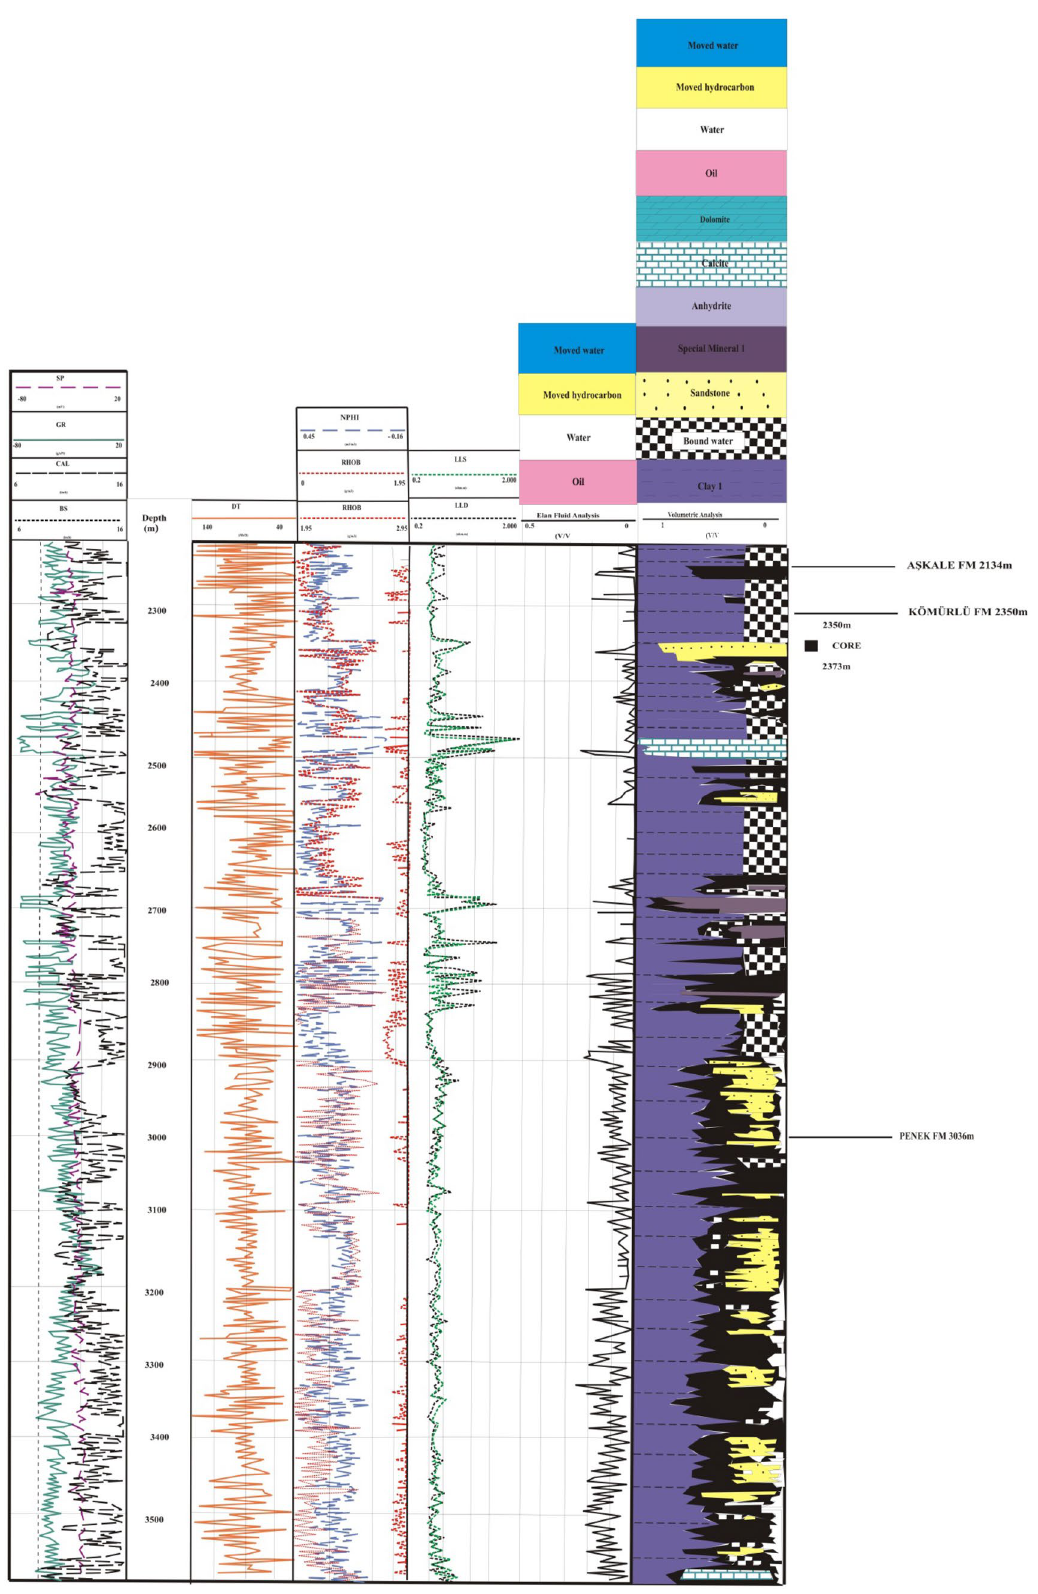
Fig. 14 Wire-line logs and lithology section from computer